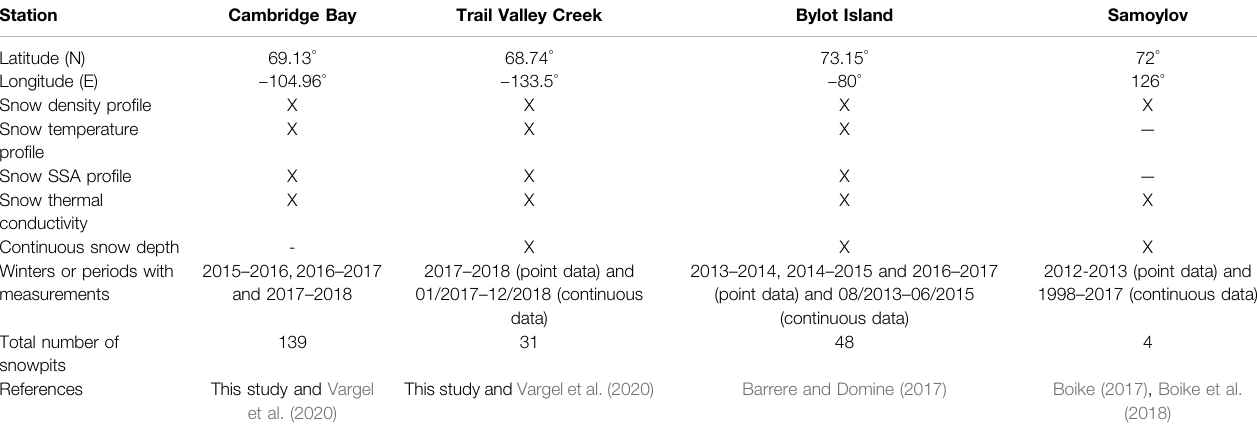
TABLE 1 | Description and data availability at the four reference sites.